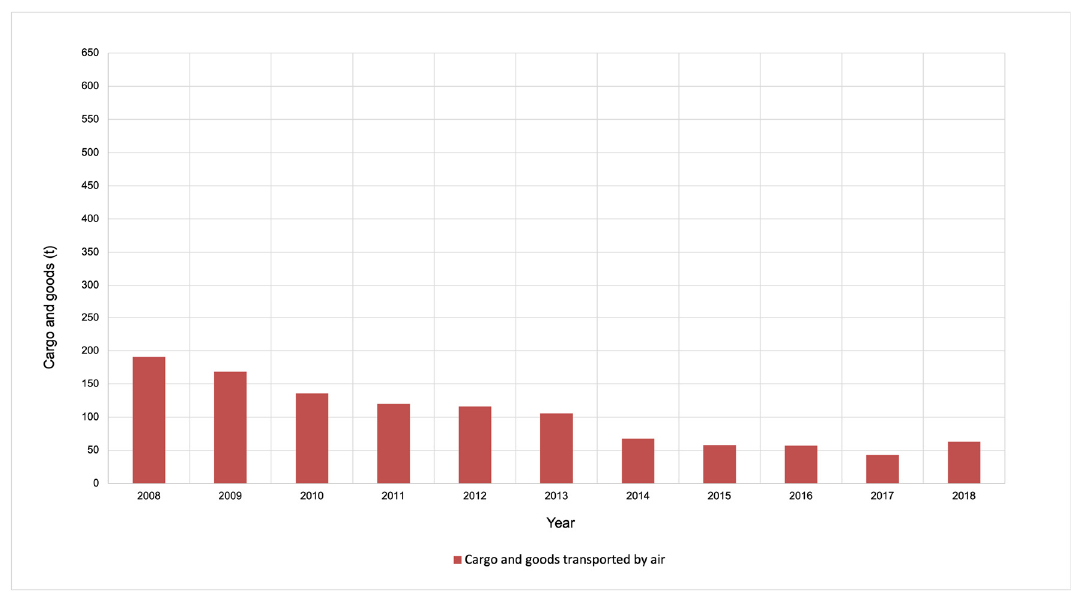
Figure 13. Cargo and goods unloaded by air in Porto Santo. (Source: Authors).